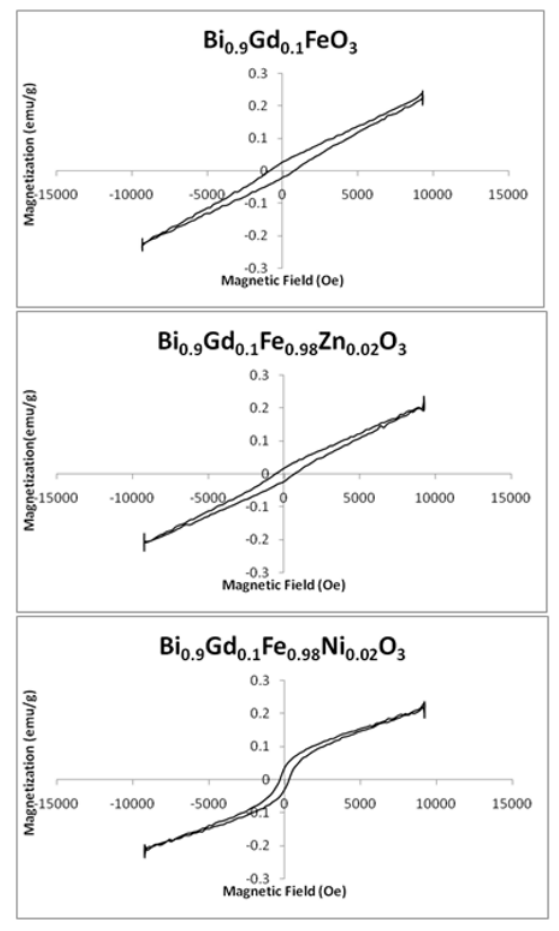
Fig. 4. The hysteresis loops of the Gd-doped